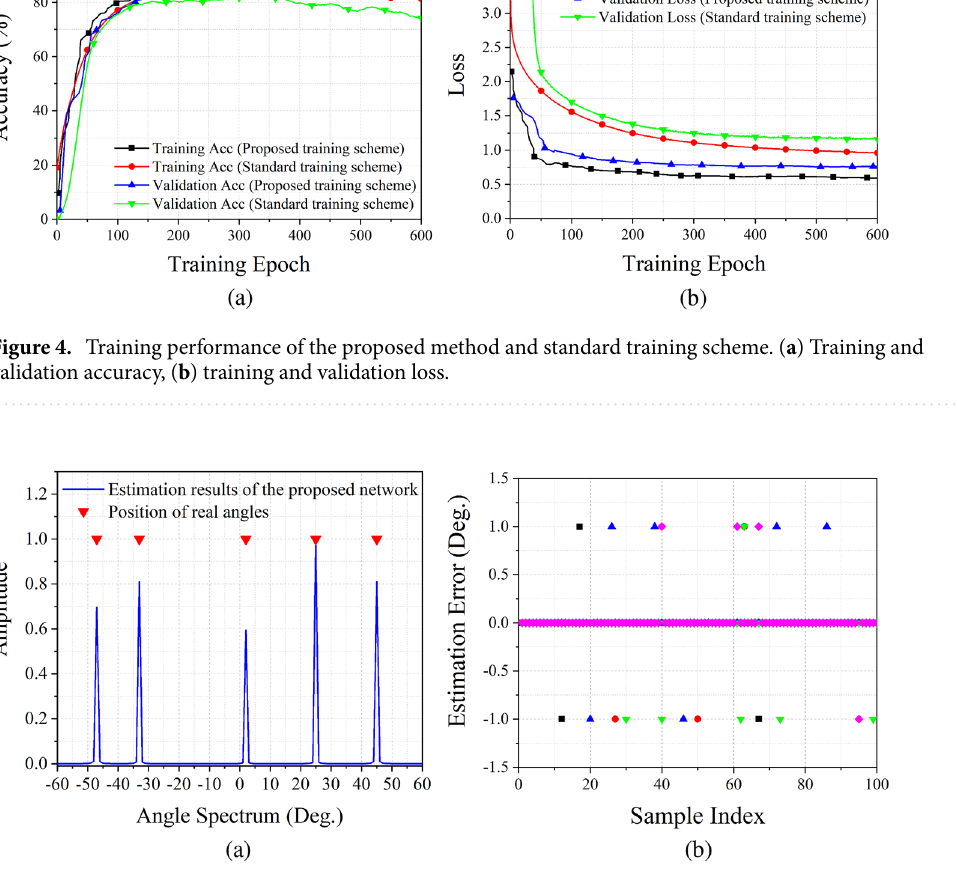
Figure 5. Estimation results of integer θ . ( a ) Angle spectrum obtained by the proposed estimation network, ( b ) estimation error for 100 Monte Carlo